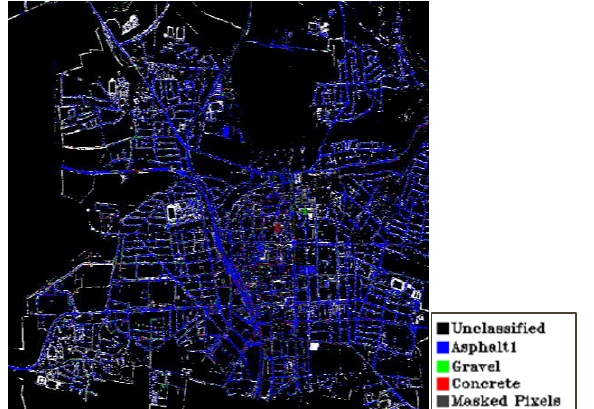
Figure 6. Classification map (mean and standard deviation